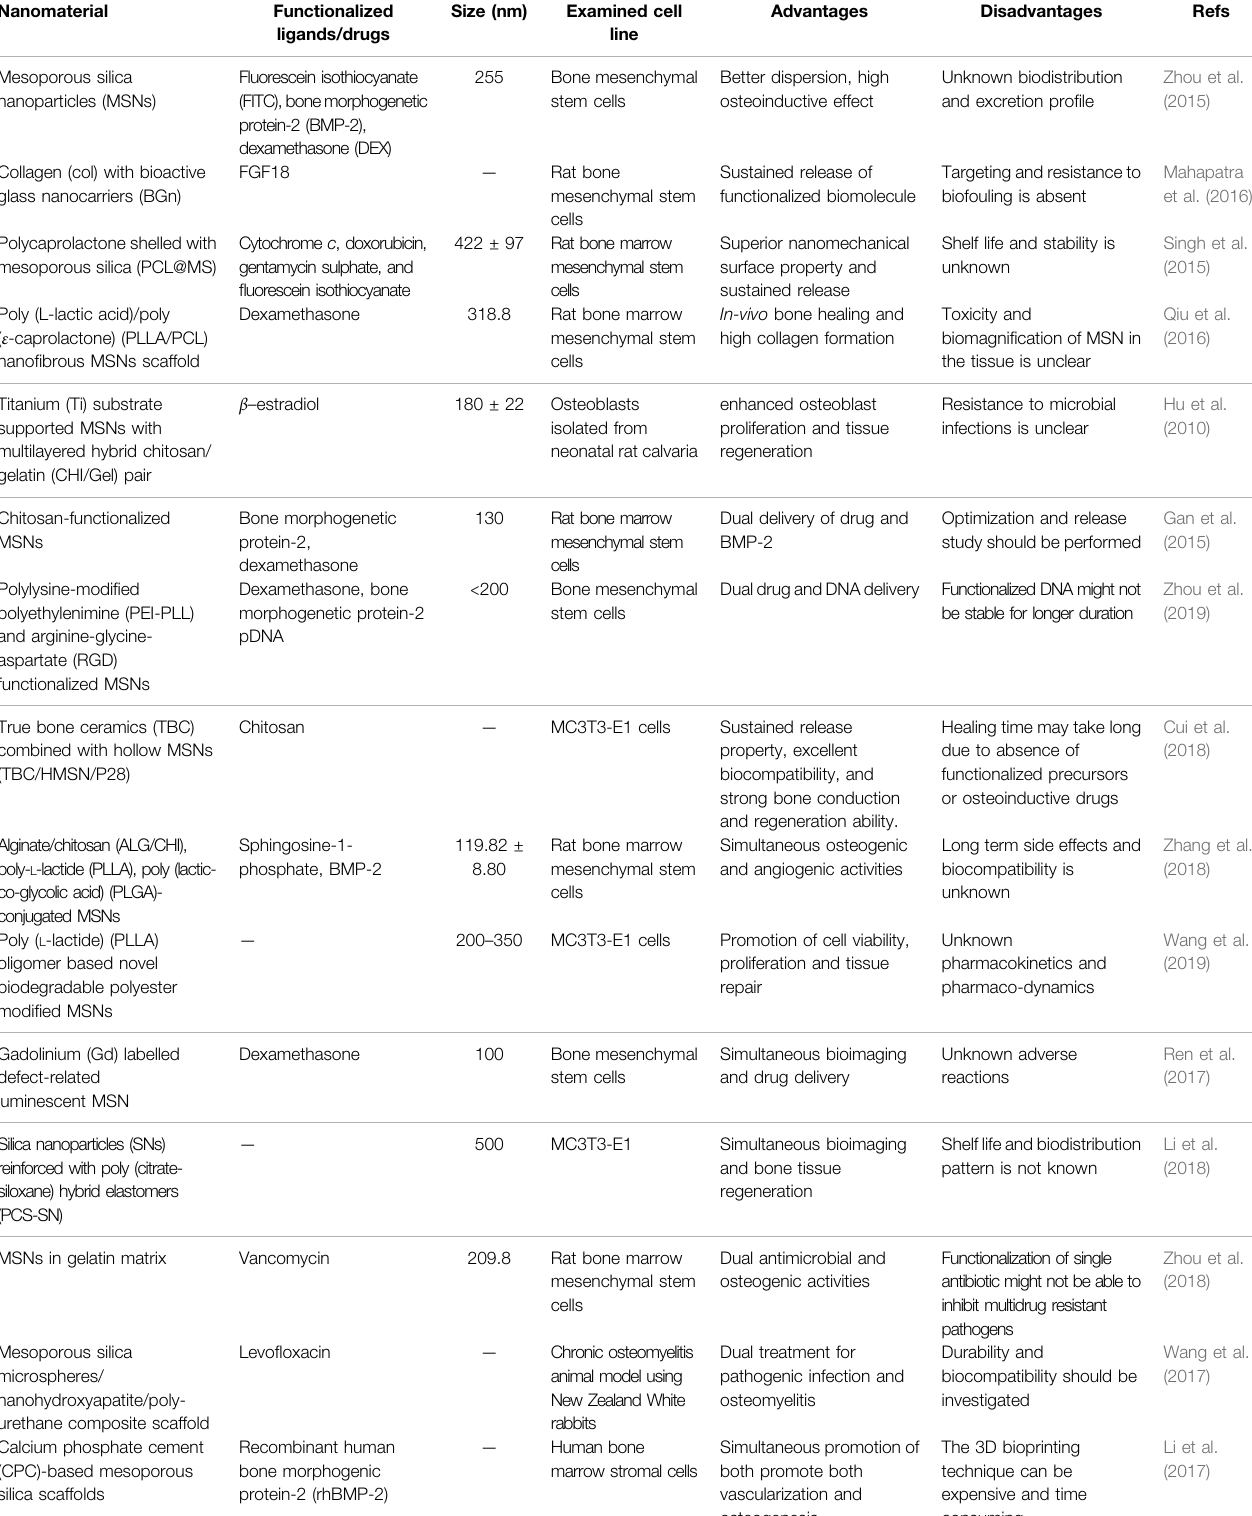
TABLE 1 | The application of MSNs as scaffolds for bone tissue